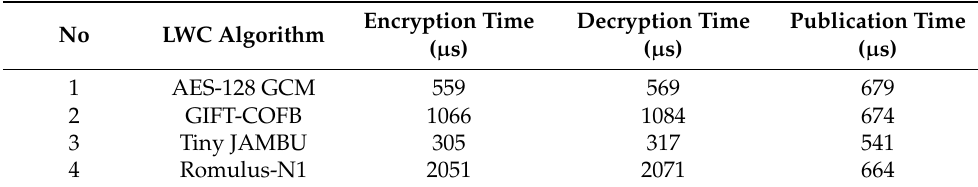
Table 6. Lightweight Cryptographic Encryption and Decryption Performance on NodeMCU with 10 Characters Messages used Registered Account.